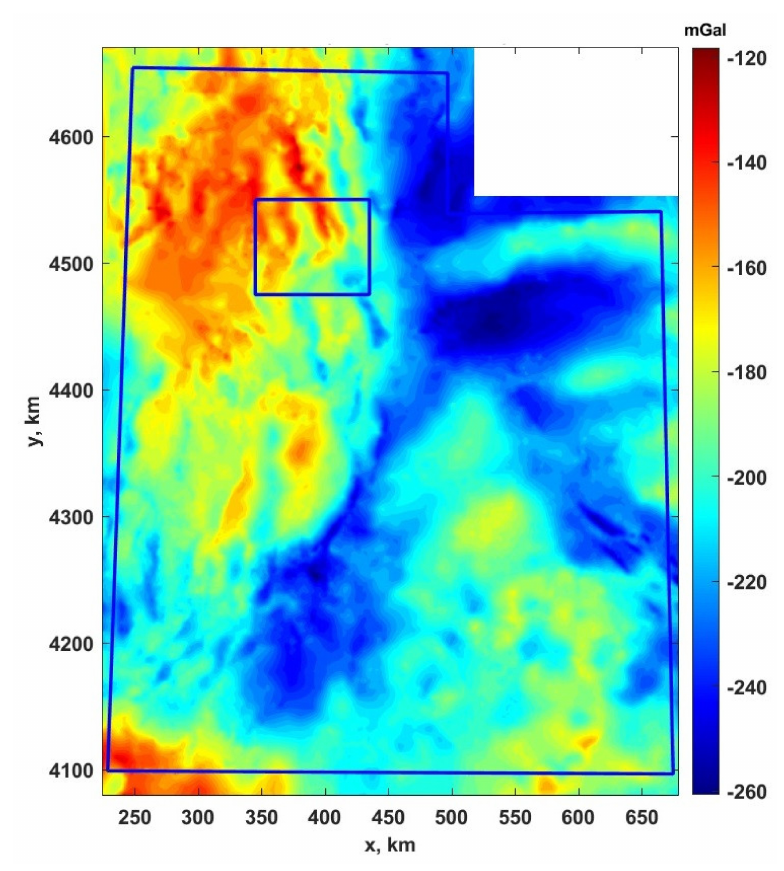
Figure 2. Utah Bouguer gravity anomaly map over the state of Utah (after USGS https://pubs.usgs. gov/of/1998/ofr-98-0761/utah_boug.htm (accessed on 1 March 2022)). A blue rectangle shown in the center of the map outlines the area of interest (AOI).